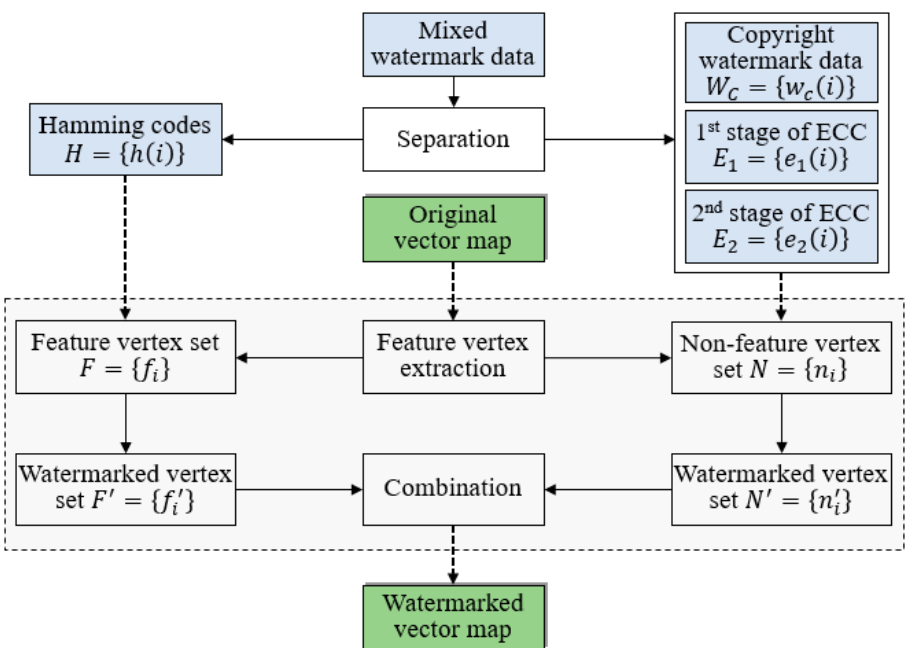
Figure 6. Diagram of vertex grouping and watermark embedding.